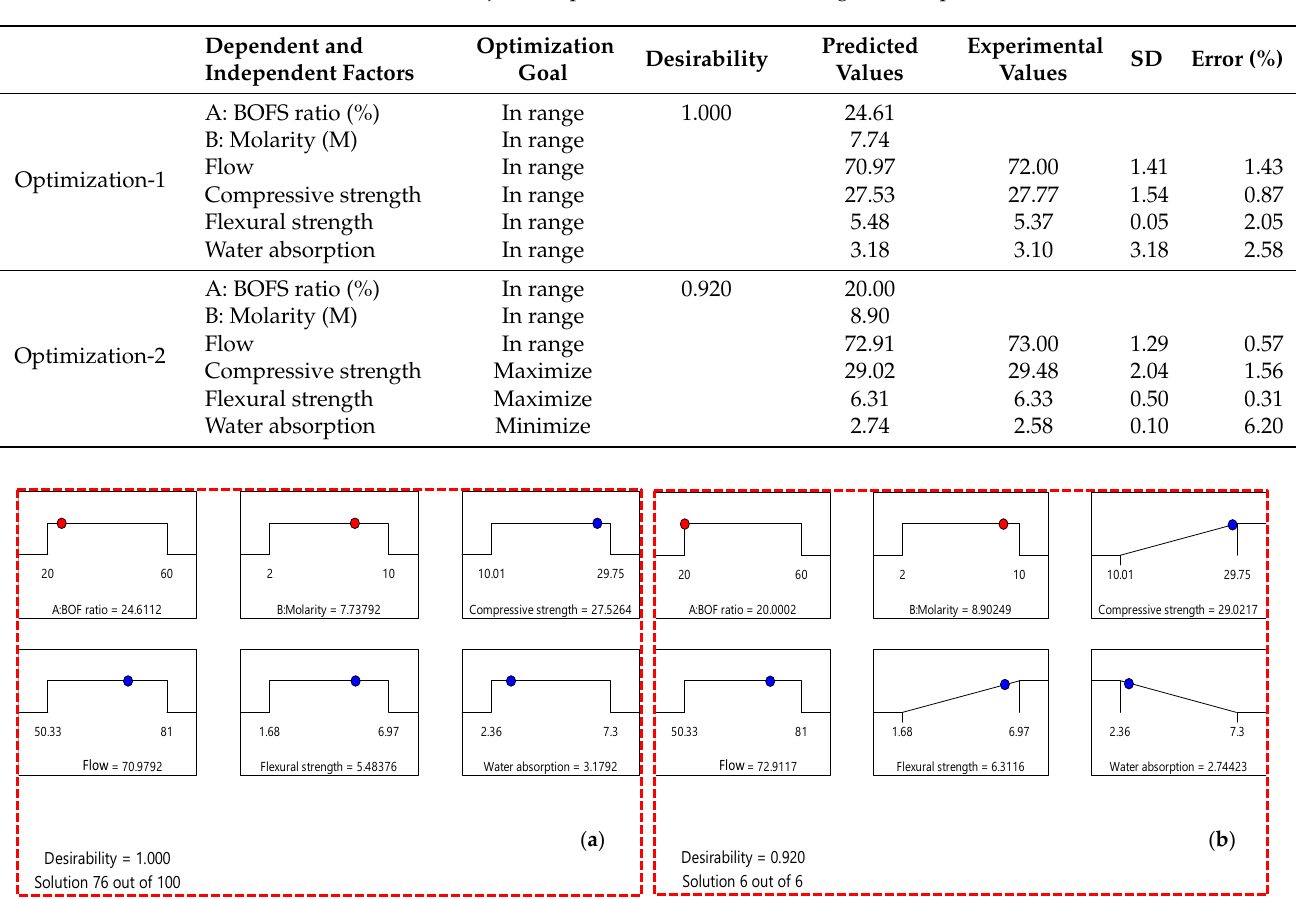
Table 6. Multi-objective optimization of the mix design and response.